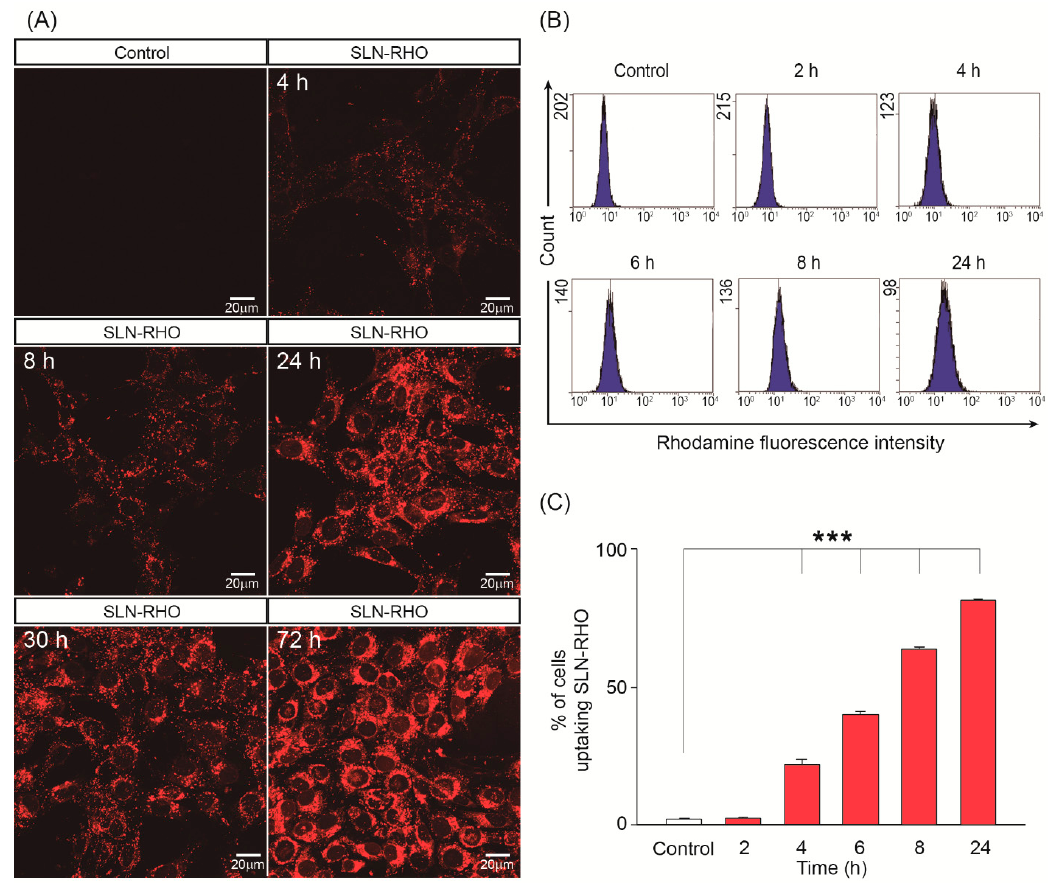
Figure 2. Uptake of SLN–RHO into HEI-OC1 cells. ( A ) HEI-OC1 cells were incubated with 250 µg/mL of rhodamine-loaded SLN (SLN–RHO). Fluorescence intensity of incorporated SLN–RHO was detected by confocal microscopy at the times indicated. Representative microphotographs from three independent experiments are shown. ( B ) HEI-OC1 cells were incubated with SLN–RHO (250 µg/mL) for different times, cells were then collected, and the fluorescent intensity of incorporated SLN–RHO was detected by flow cytometry. The plots shown are representative of three independent experiments, whose quantification is shown in ( C ). Data are shown as the mean ± SEM from three independent experiments. One-way ANOVA was used to determine statistical significance; *** p < 0.001.